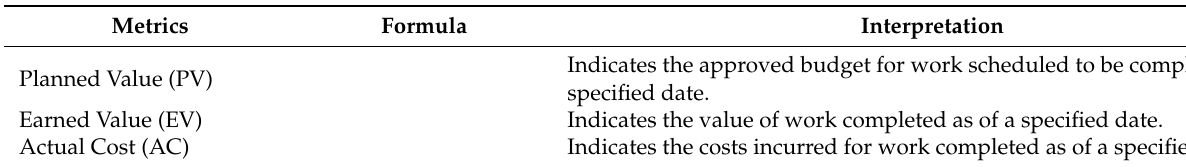
Table 1. Basic EVM metrics [30].